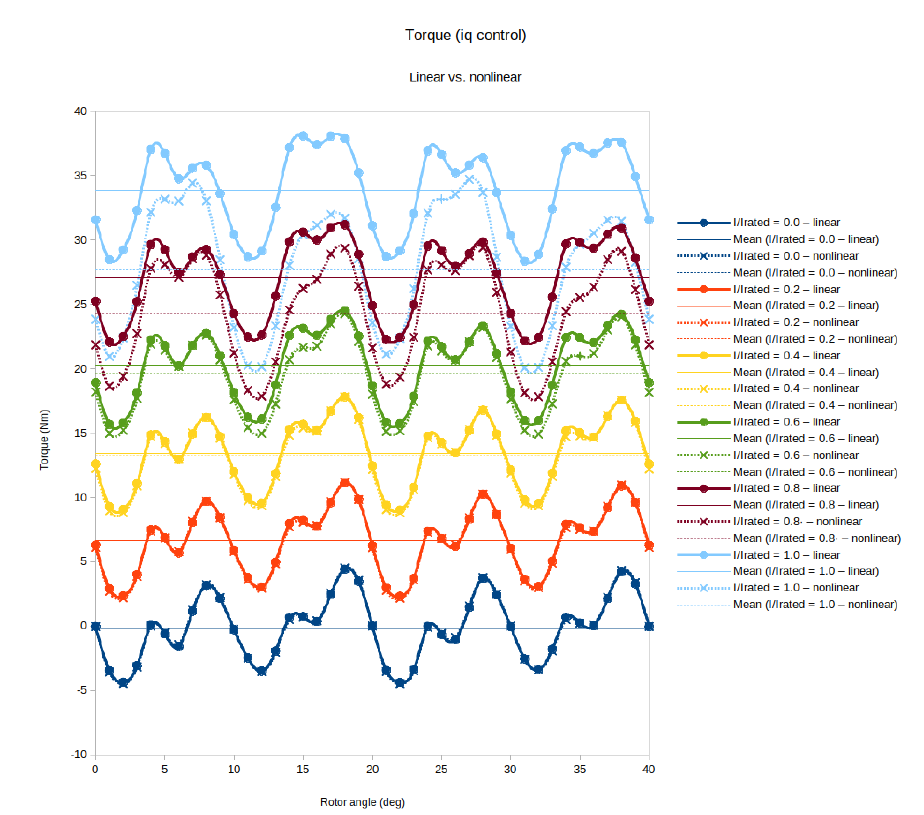
Figure 11. Torque for different positions and currents under i q control.